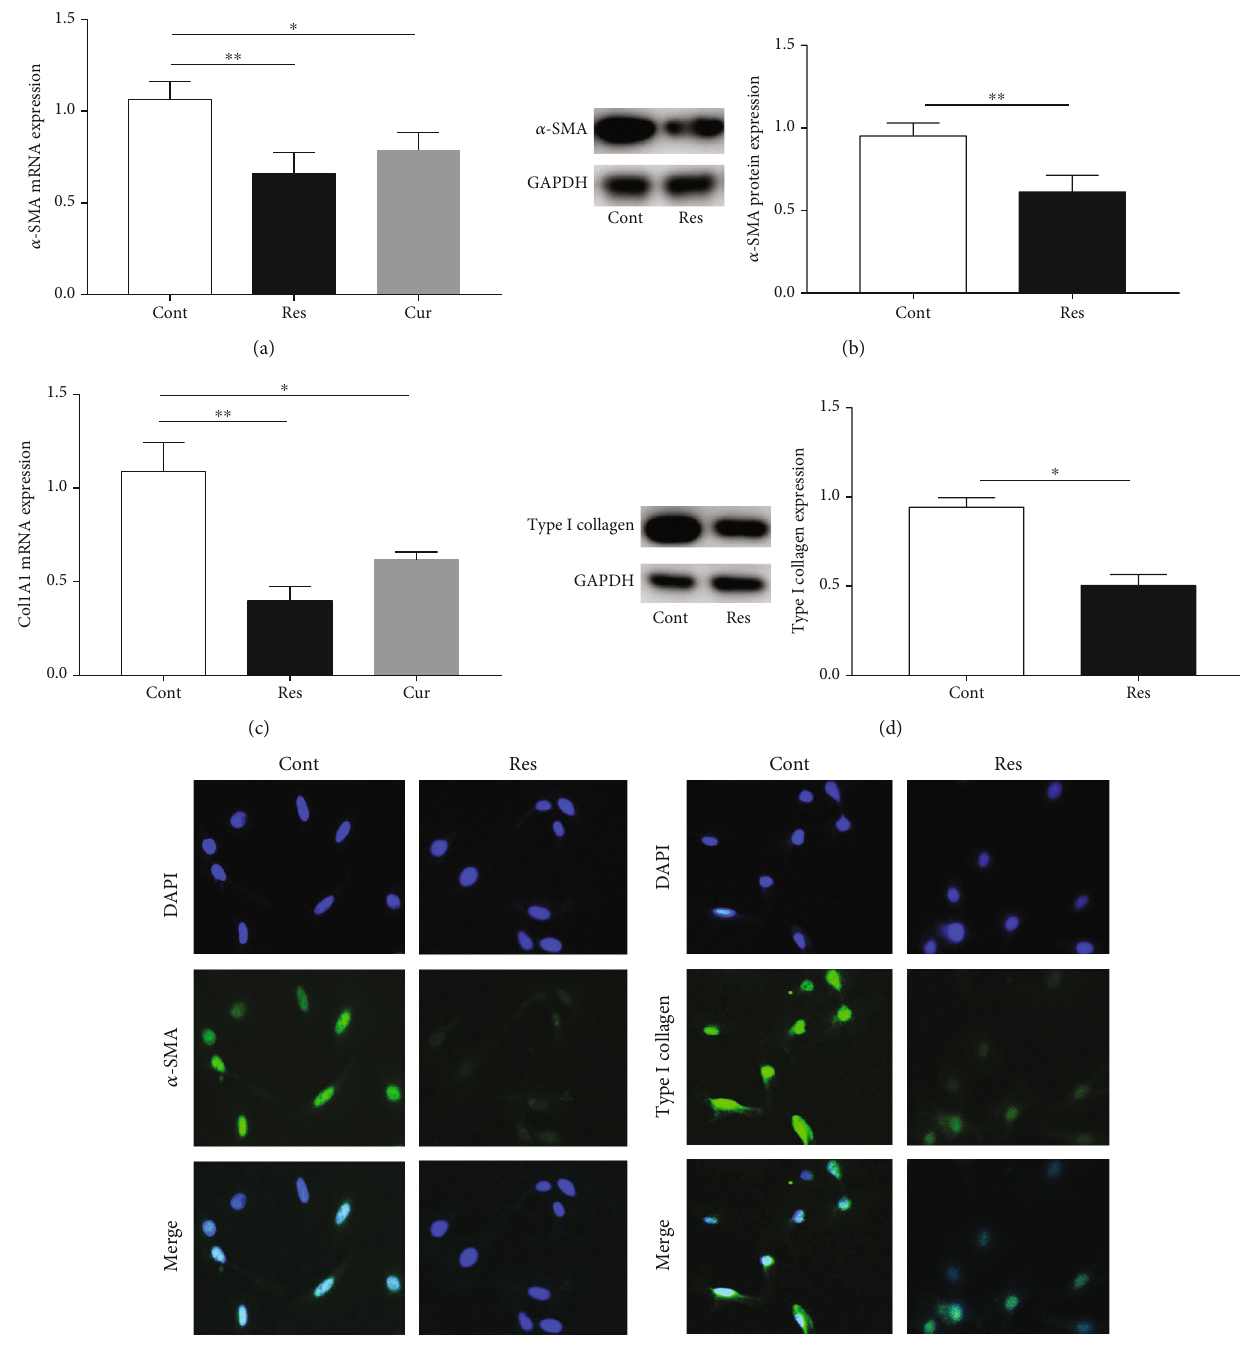
Figure 3: E ff ects of Res on HSC transdi ff erentiation and collagen deposition. (a, c) mRNA expression of α -SMA and Col1A1 . (b, d) Protein expression of α -SMA and type I collagen. (e, f) Immuno fl uorescence staining for α -SMA and type I collagen. Nuclei are stained blue with DAPI. Original magni fi cation: × 200. Values are expressed as means ± SD . ∗ P < 0 : 05 and ∗∗ P < 0 : 01